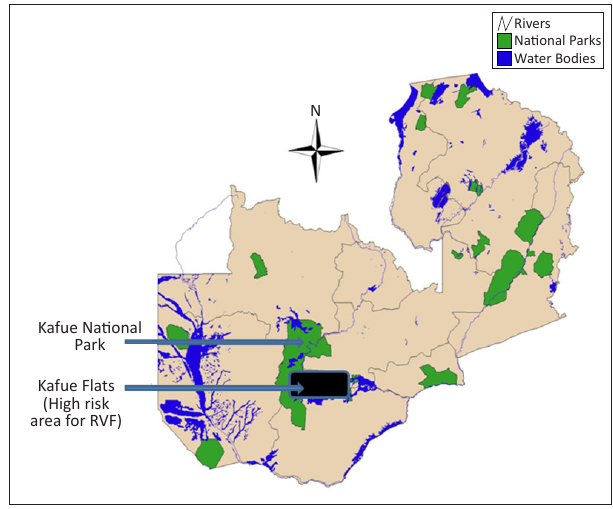
FIGURE 1: Map of Zambia showing the location of the Kafue Flats.